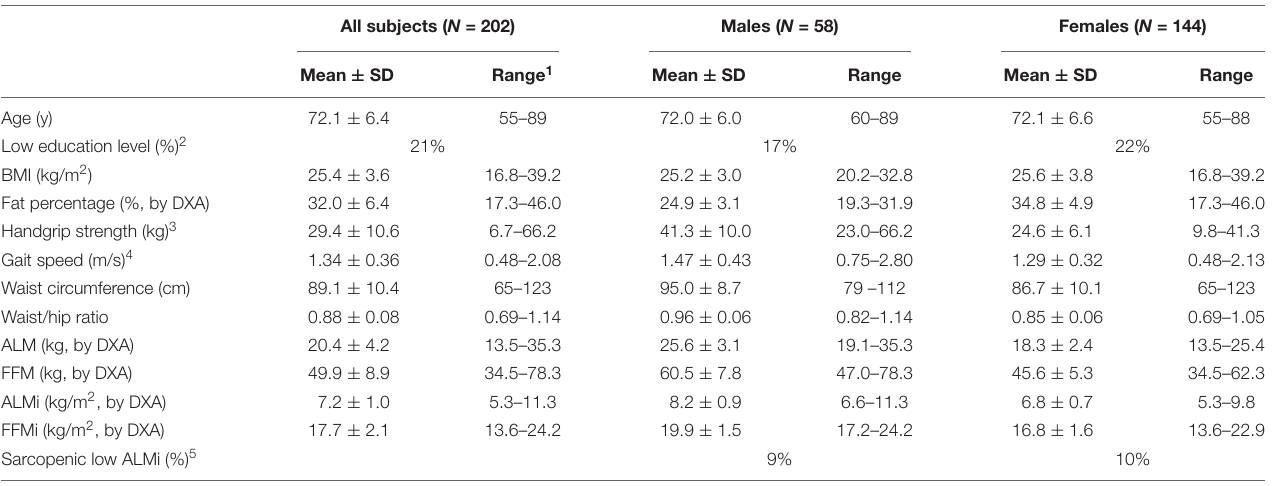
TABLE 1 | Baseline characteristics of 202 older subjects of the VITAMIN-trial 1